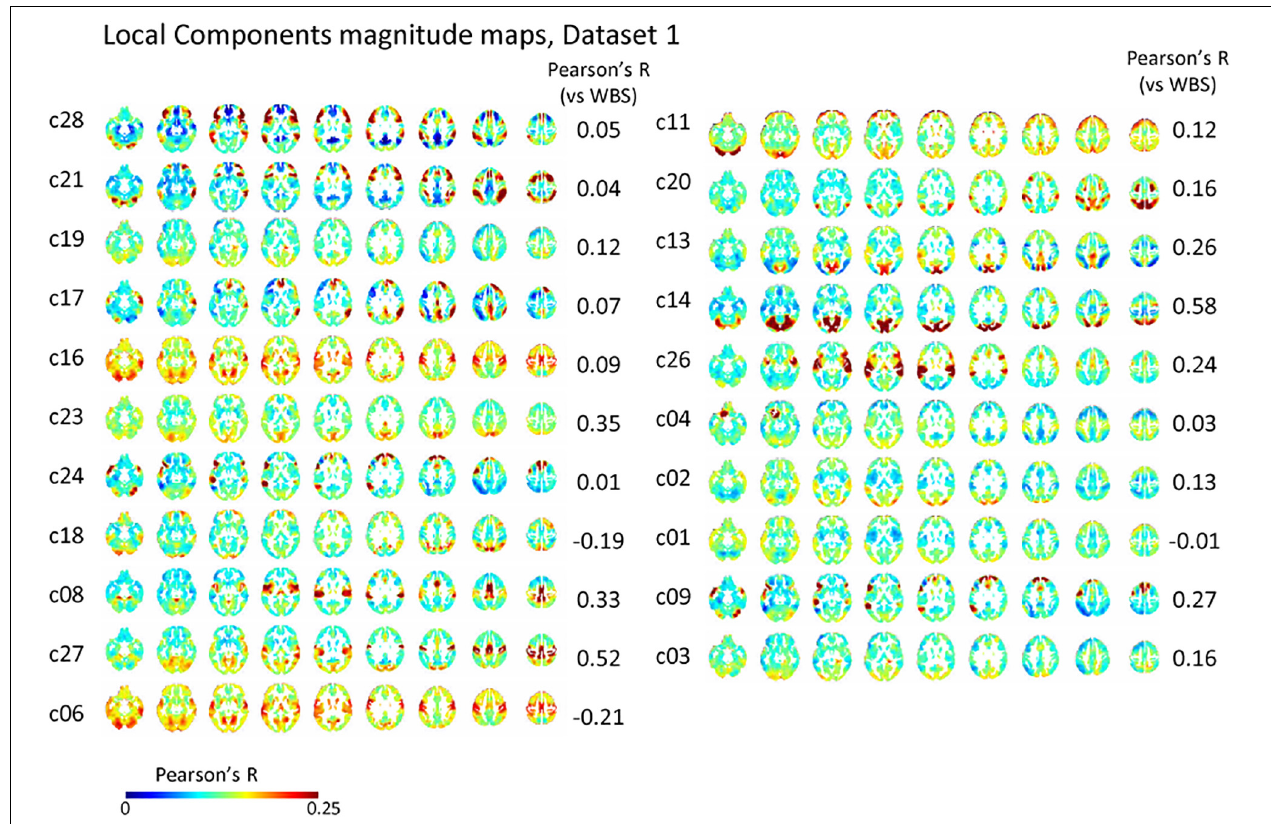
FIGURE 5 | Local component. The spatial distribution of the magnitude of the temporal ICA components for test dataset demonstrates a set of local ICs. Each IC shows significant synchronization within functionally relevant structures that would correspond to spatial maps for the temporally independent functional modes (Smith et al.,